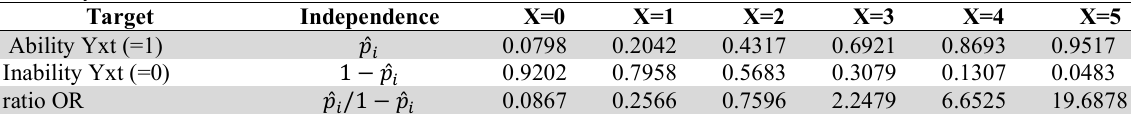
Probability level at vector X0